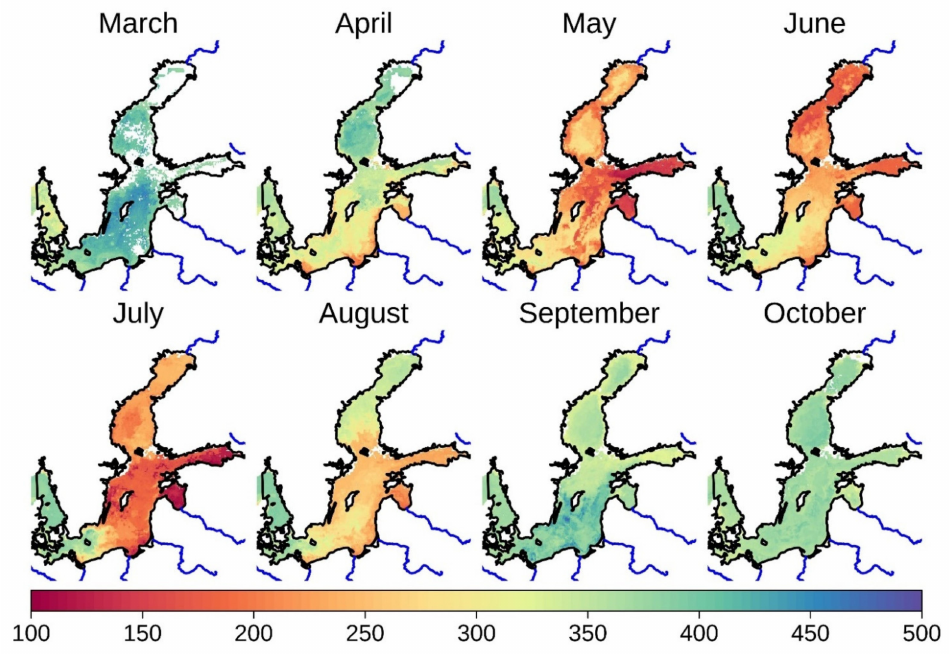
Figure 5. Seasonal distribution of pCO 2 in the Baltic Sea in the year of 2005 and the large rivers draining to the Baltic Sea. The sea surface pCO 2 in the Baltic Sea exhibited significant seasonal variations (Figure